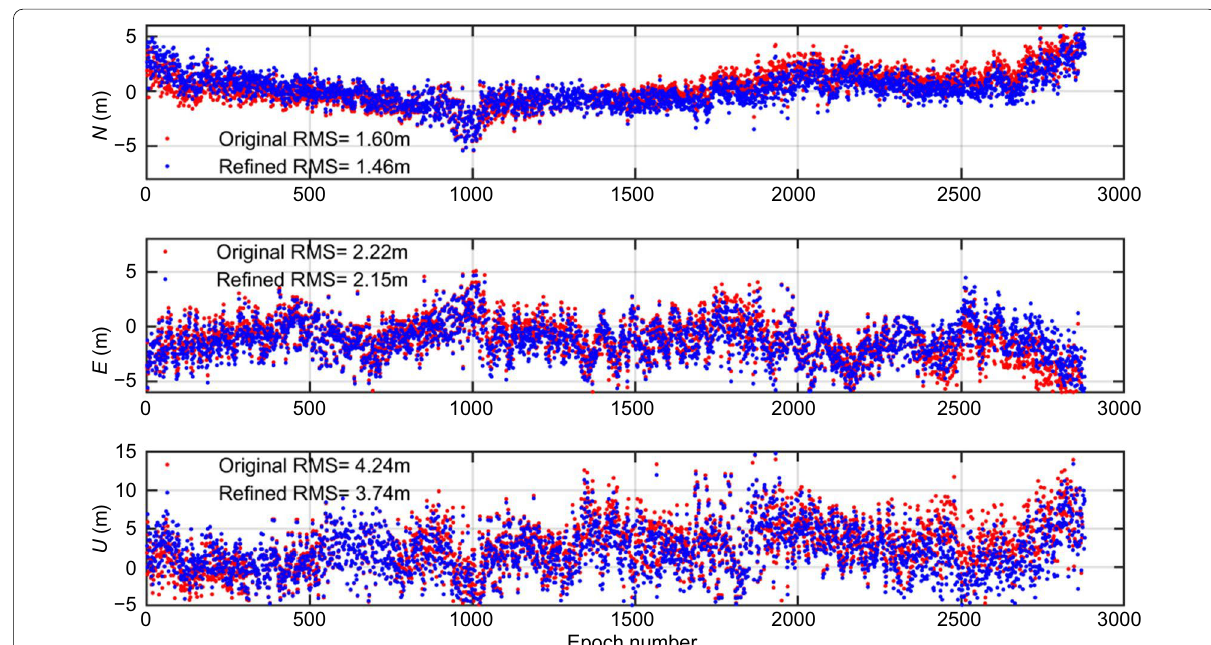
Fig. 8 SPP validation results of the original ODTS orbits and refined orbits on DOY 148 in 2017. Observations of GEO and IGSO satellites are used, and red and blue represent the results using original and refined orbits,